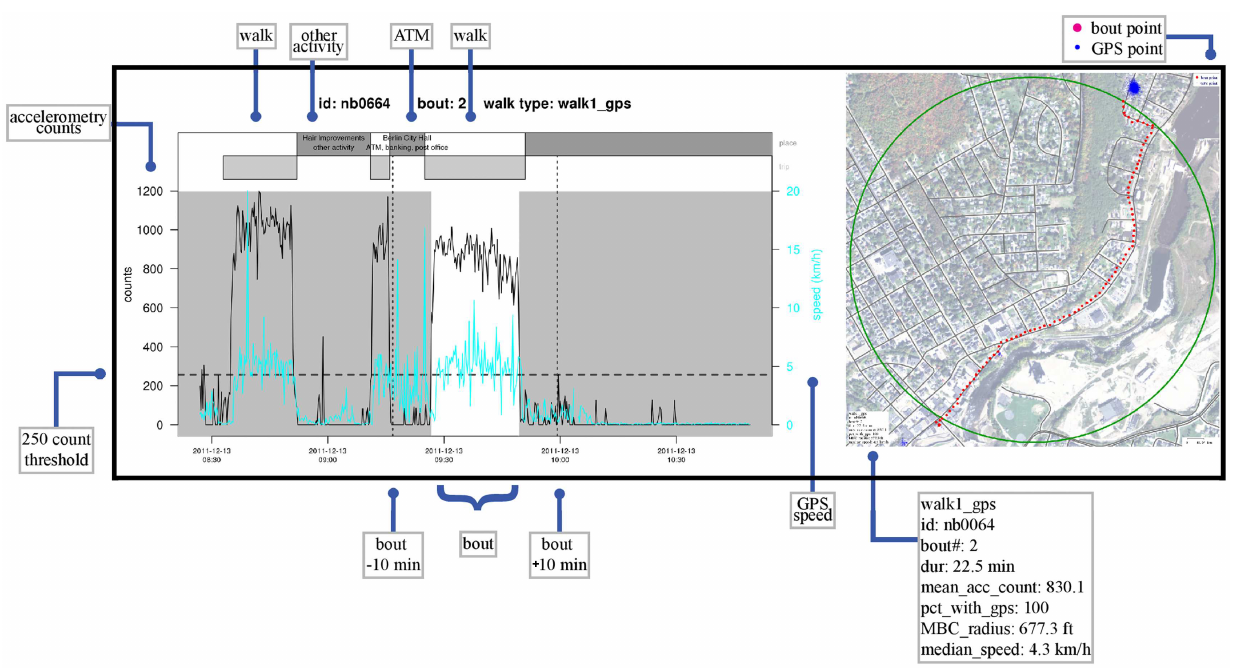
FIGURE 9 |An illustration of LifeLogView for a single bout of activity for one subject . Left panel: time-indexed combined accelerometry counts (black lines), global positioning system (GPS) speed (cyan lines), and place and trip data from a travel diary (gray boxes with text labels). A physical activity bout is centered in the graph within a white background.The dashed horizontal line